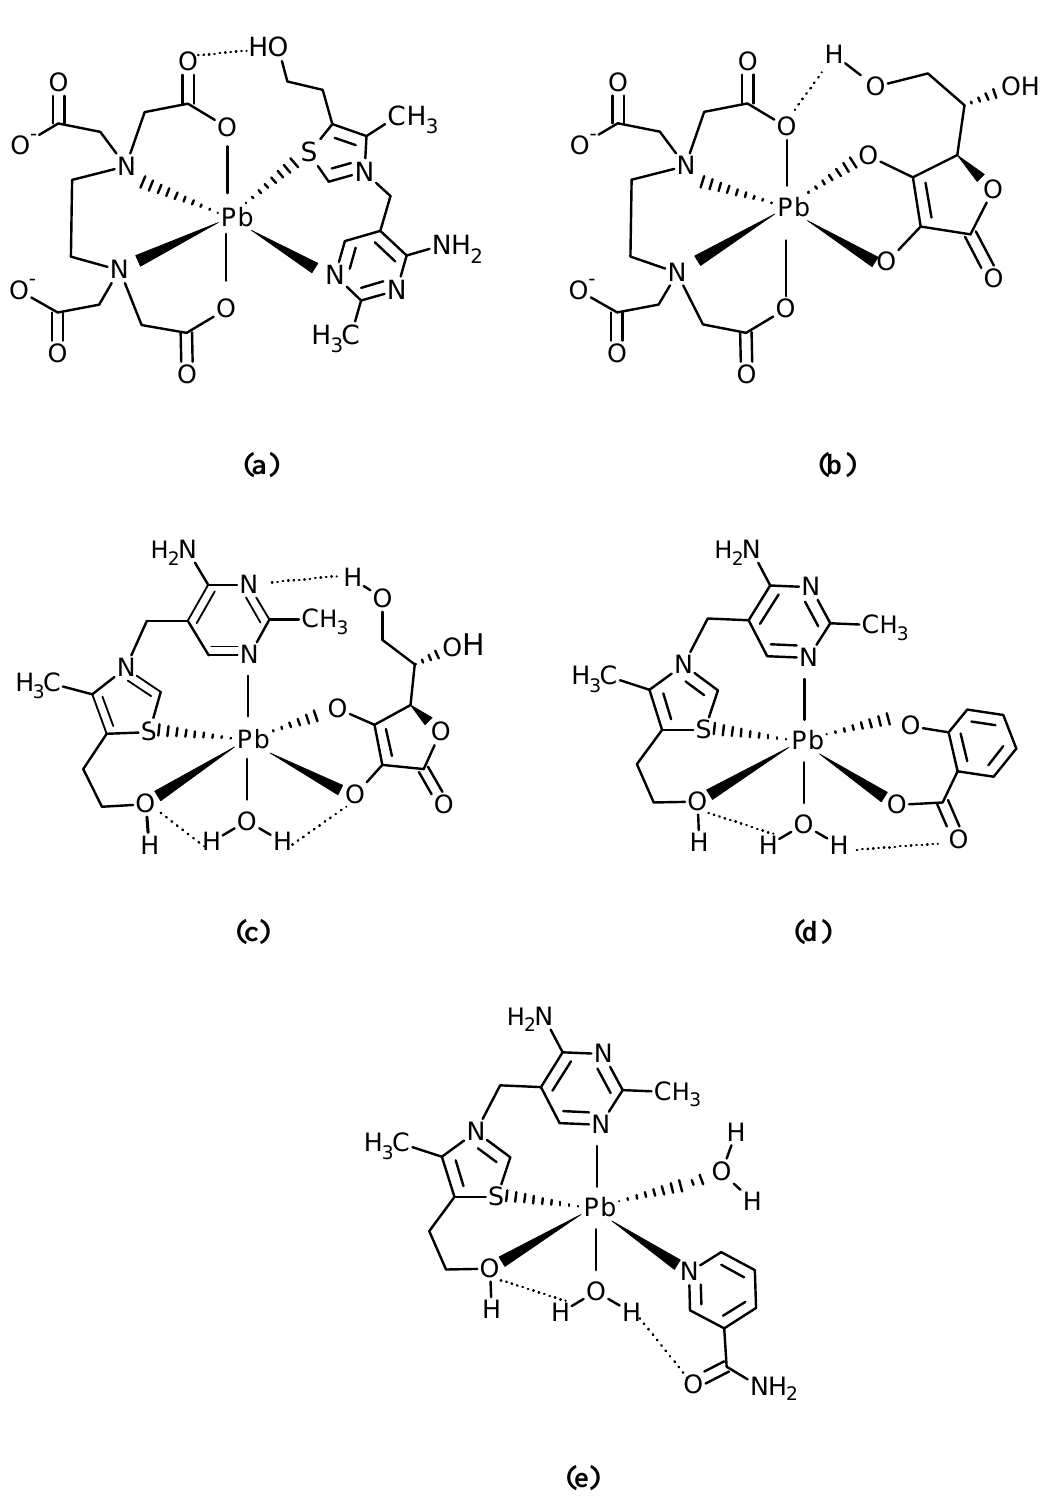
Figure 5: Proposed structures for mixed ligand complexes in in-vitro conditions; (a) Pb(EDTA)(Vit B 1 ) (b) Pb(EDTA)(AsC) (c) Pb(Vit B 1 )(AsC) (d) Pb(Vit B 1